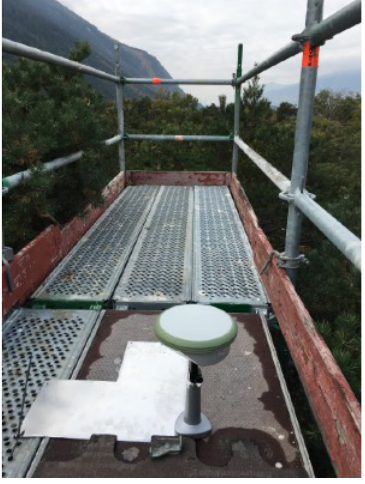
Figure 7. Ground control point with differential GNSS antenna at test site